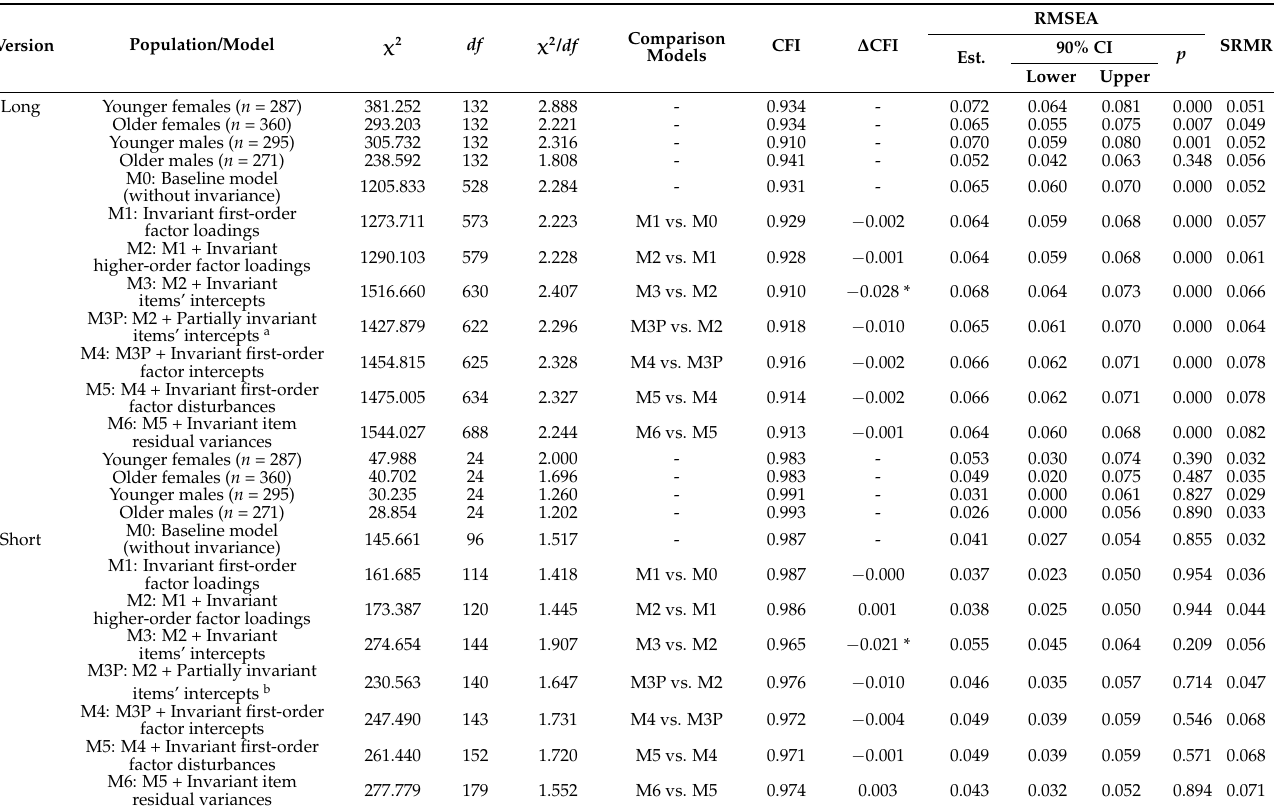
Table 2. Goodness-of-fit indexes across population subgroups and invariance testing of the long and short versions of the